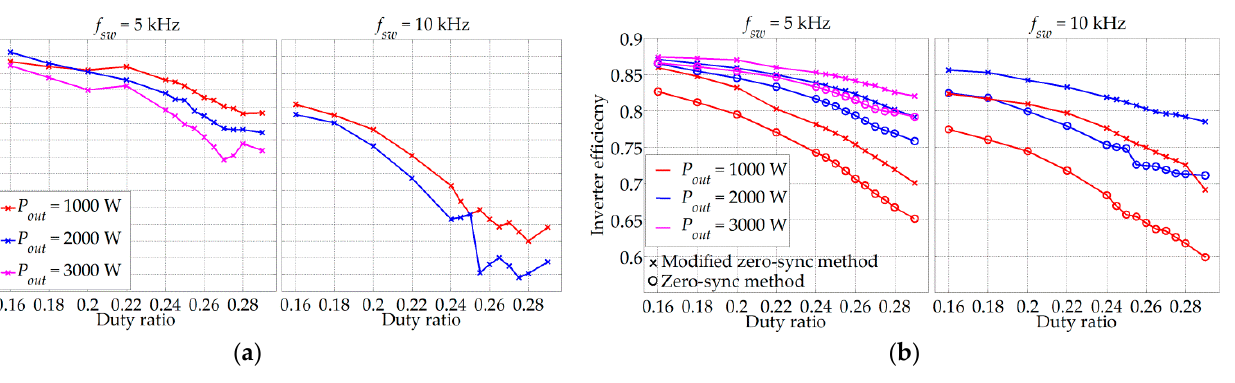
Figure 17. Waveforms of the output load phase current and the qZSI input current in case of implementing the zero-sync method with dead-time.